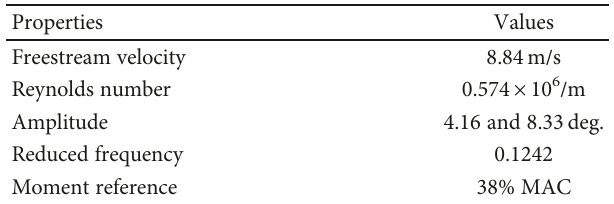
Figure 5: Structured mesh for ICE con fi guration. Table 3: Wind tunnel test conditions for forced